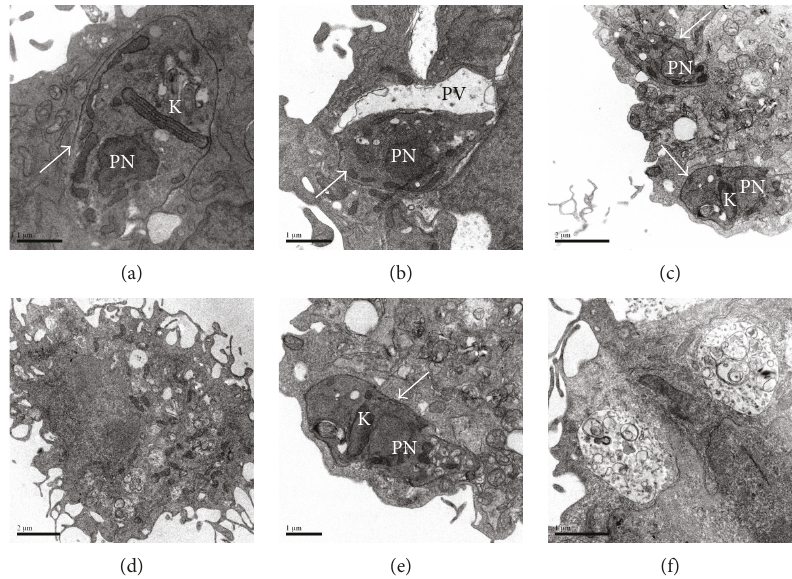
Figure 8: Ultrastructural analysis of T. cruzi infected MSC. Viable parasites were found in the cytosol of MSC-WT (a) and inside parasitophorous vacuoles of MSC-Gal3KD (b), 24h after infection. (c and e) Viable parasites are seen in the cytosol of MSC-WT 72 h after infection. (d and f) Absence of viable parasites and presence of large vacuoles containing degraded material in the MSC-Gal3KD 72 h after infection. White arrows=viable parasites ’ ; K=kynetoplast; PN =parasite nucleus; PV=parasitophorous